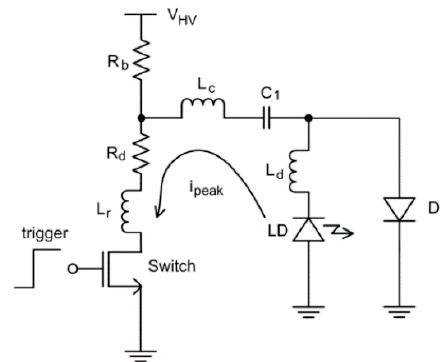
Figure 11. Typical laser driver circuit. Reproduced with permission from H. Zhong, T. Duan, H. Lan, M. Zhou, F. Gao, Sensors, Vol.18, Article ID2264, 2018; licensed under a Creative Commons Attribution (CC BY) license.